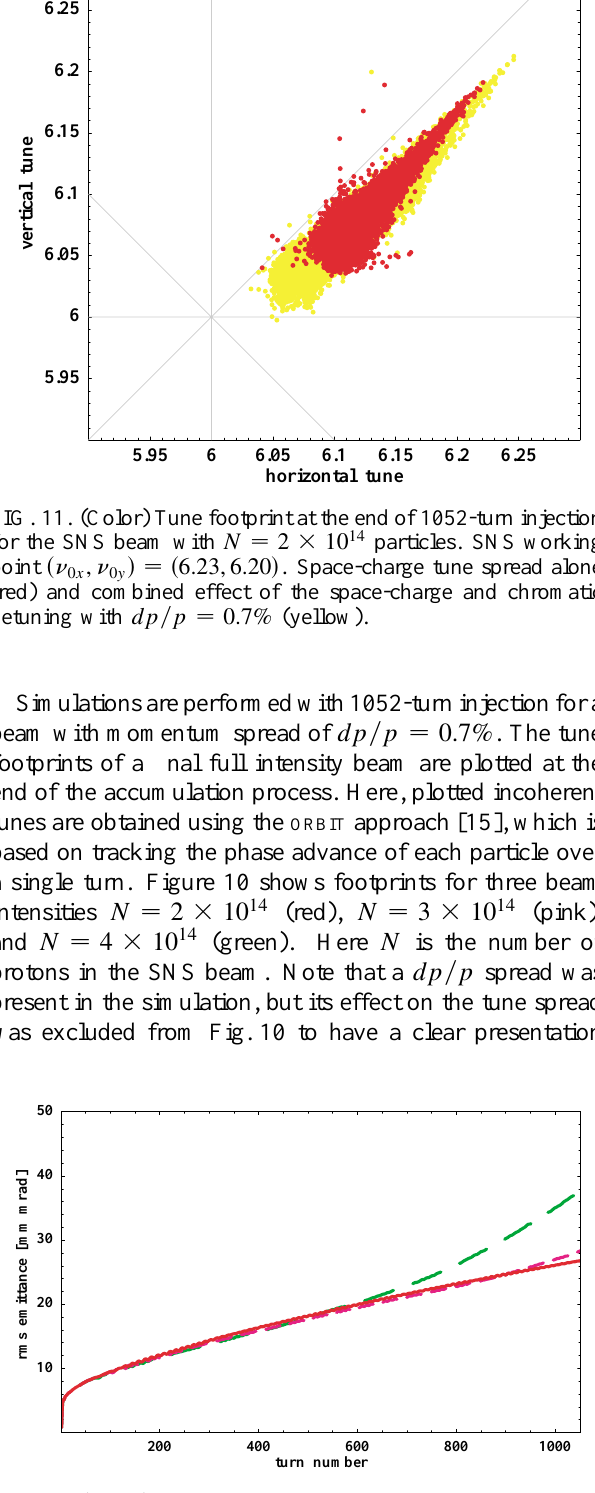
FIG. 10. (Color) Tune footprints at the end of 1052-turn injec- tion process for the SNS beam. Intensities: N (cid:1) 2 3 10 14 (red), N (cid:1) 3 3 10 14 (pink), and N (cid:1) 4 3 10 14 (green) in the absence of magnet errors. SNS working point (cid:3) n 0 x , n 0 y (cid:4) (cid:1) (cid:3) 6.23, 6.20 (cid:4) .